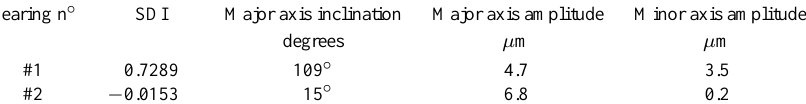
Table 3 Parameters of the 1X filtered orbits caused by the machine residual unbalance. Analysis of experimental